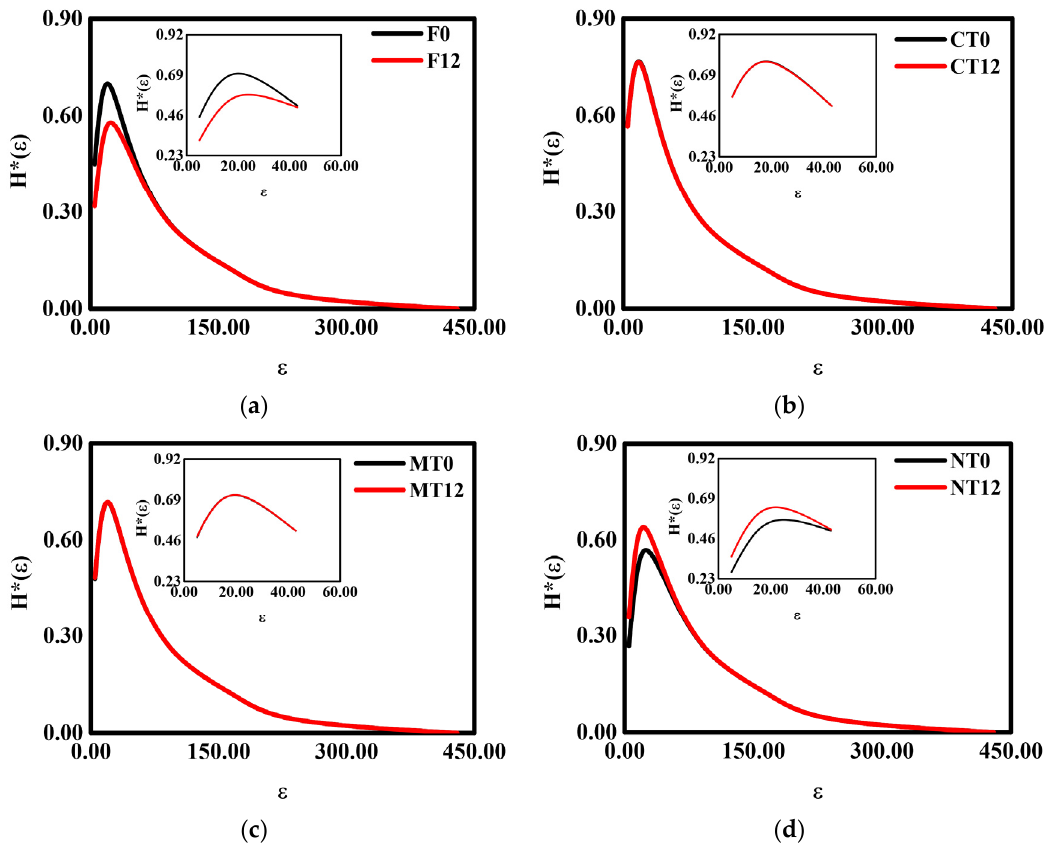
Figure 4. The 3D normalized Shannon’s entropy (H*( ε )) of the samples submitted to 0 and 12 wetting and drying (W-D) cycles. ( a ) Secondary forest—F; ( b ) conventional tillage—CT; ( c ) minimum tillage—MT; ( d ) no tillage—NT. The smaller graphs represent a zoomed-in region with the most significant variation (F and NT) between the curves. ε is the box size.